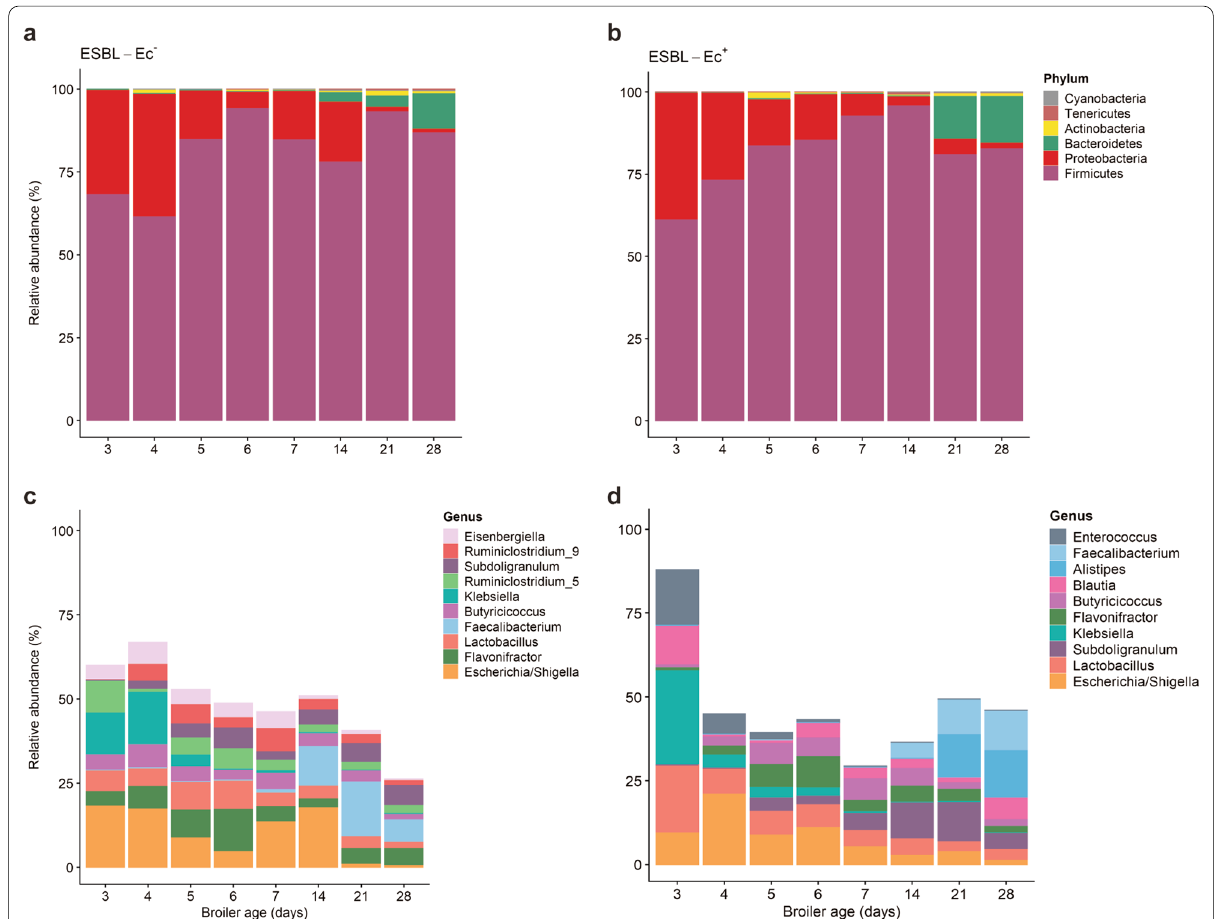
Fig. 2 Caecal microbiota composition of ESBL‑Ec − and ESBL‑Ec + broilers. a – b Relative abundance of bacterial phyla of ESBL‑Ec − and ESBL‑Ec + broilers from day 3–28. c – d Relative abundance of the top ten genera of ESBL‑Ec − and ESBL‑Ec + broilers. The relative abundance of each phylum and genus is shown in decreasing order from bottom to